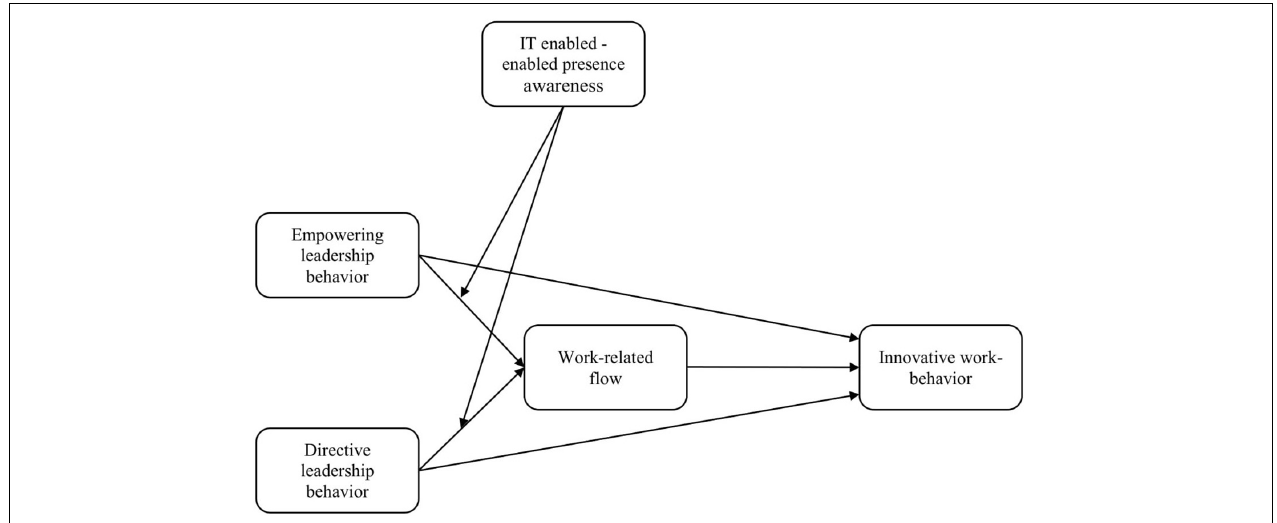
FIGURE 1 | Hypothesized relationships in the conceptual